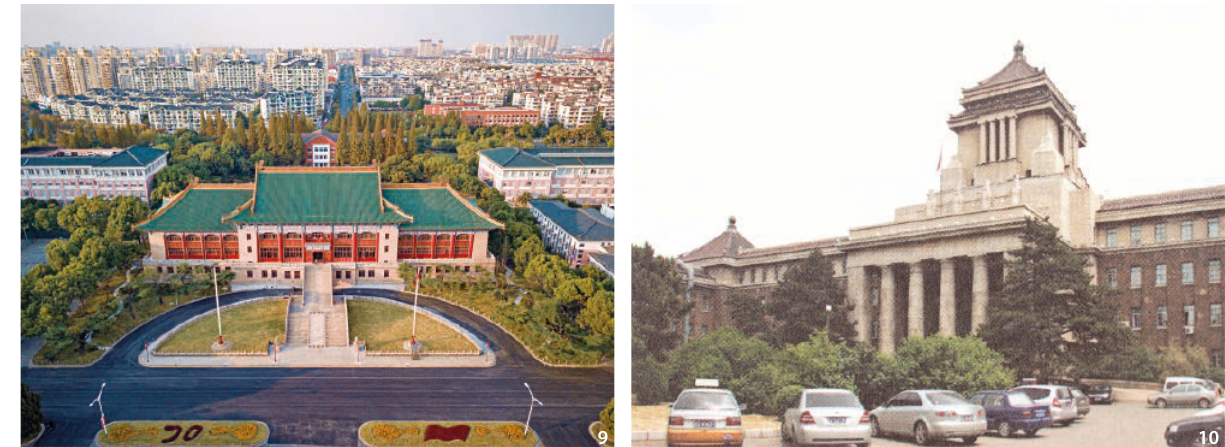
Figure 9 Shanghai City Hall for the Greater Shanghai Plan, designed by Dong Dayou, 1933 (Source: https://zh.wikipedia.org/wiki/%E5%A4 %A7%E4%B8%8A%E6%B5%B7%E8%AE%A1%E5%88%92). Figure 10 Bethune Basic Medical College Building of Jilin University, Changchun (the former State Council Building of Manchukuo), 1936 (Source: J. Zhang 2018,